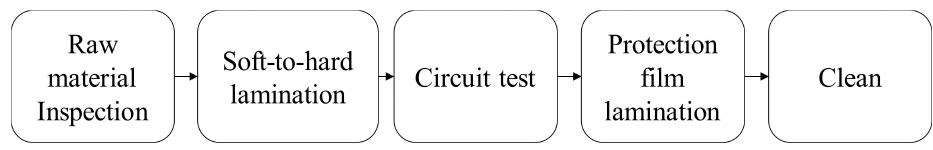
Figure 2. Optical film lamination in the LCM